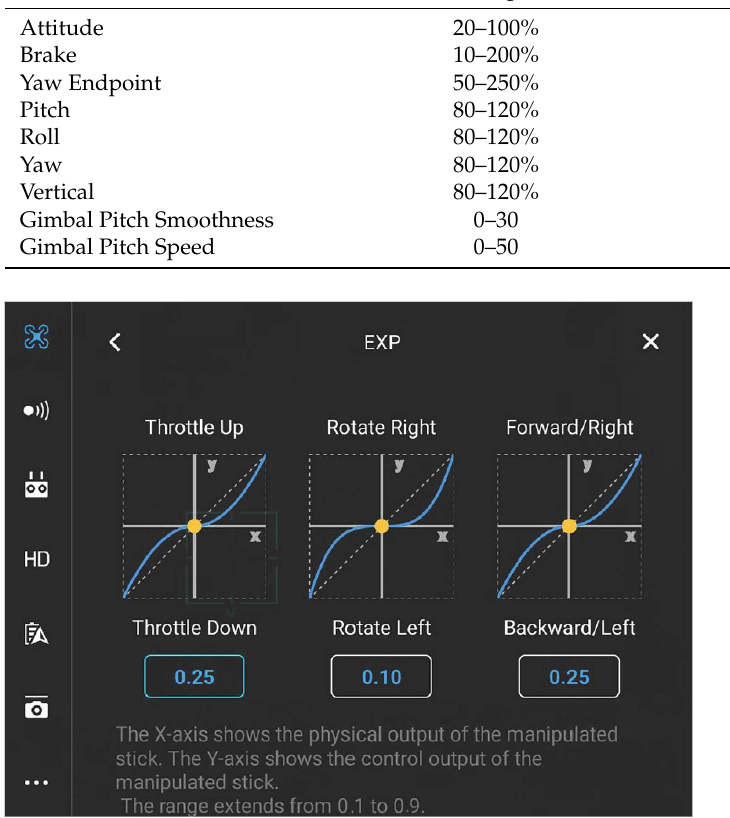
Figure 2. Screenshot of the characteristics of the control knobs; Source: own